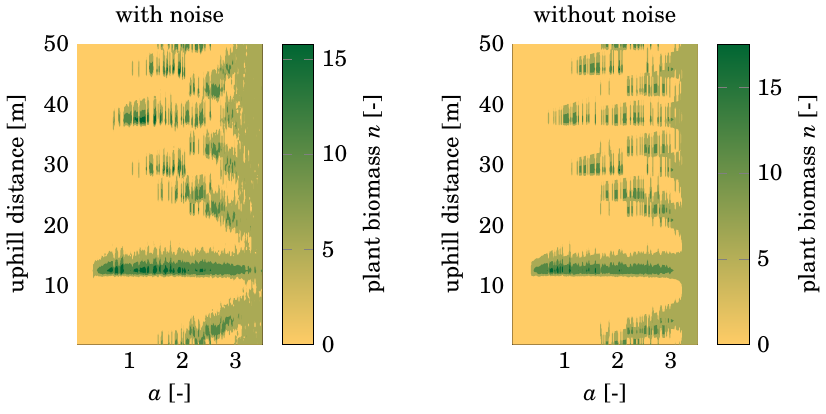
Figure 5. Results of the one-dimensional Klausmeier model after 1500 time-steps are shown for constant precipitation. Resulting biomass peaks are shown for different values of the parameter a . The maximum of plant biomass is located at 12.5 m uphill distance for each run. Varying random initial conditions have been used. For the generation of the left plot, the stochastic differential equation given by Equation (26) has been used for calculation of the plant